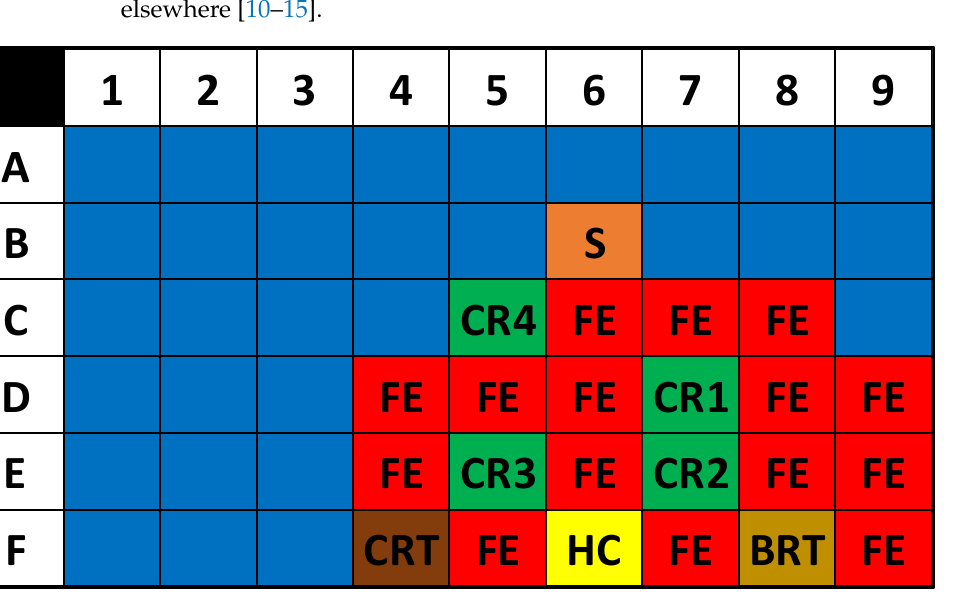
Figure 1. MSTR current core configuration called the “120 W” configuration. S: Source Holder; FE: Fuel Element; CR#: Control Rod; HC: Hot Cell; BRT: Bare Rabbit Tube; CRT: Cadmium Rab-bit Tube.